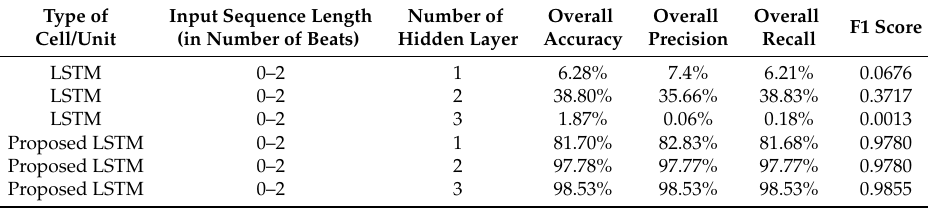
Table 6. Performance summary of the proposed bidirectional LSTM in MITDB analysis 1 of Figure 9a.